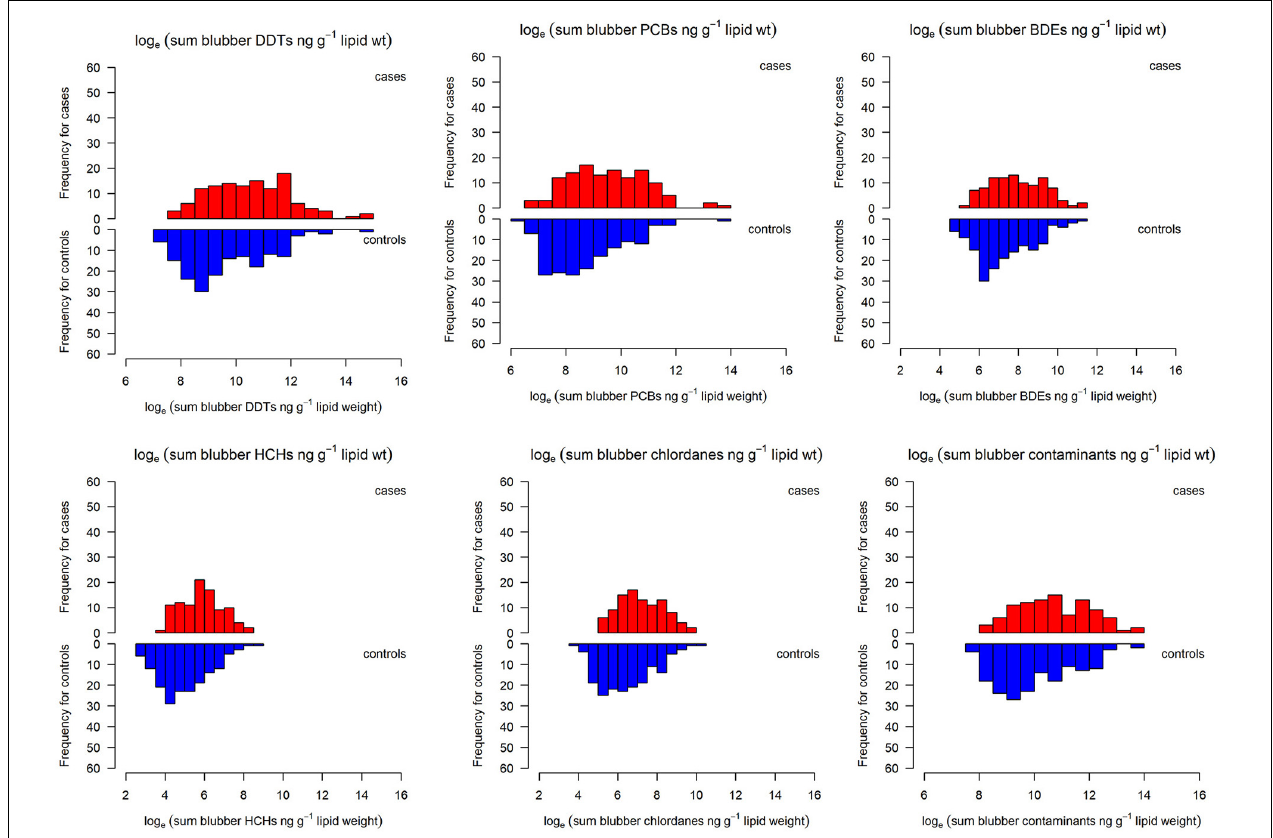
FIGURE 1 | Blubber contaminant concentrations (log e transformed, ng g − 1 on a lipid weight basis) in California sea lion cancer cases (red) and controls (blue) by contaminant